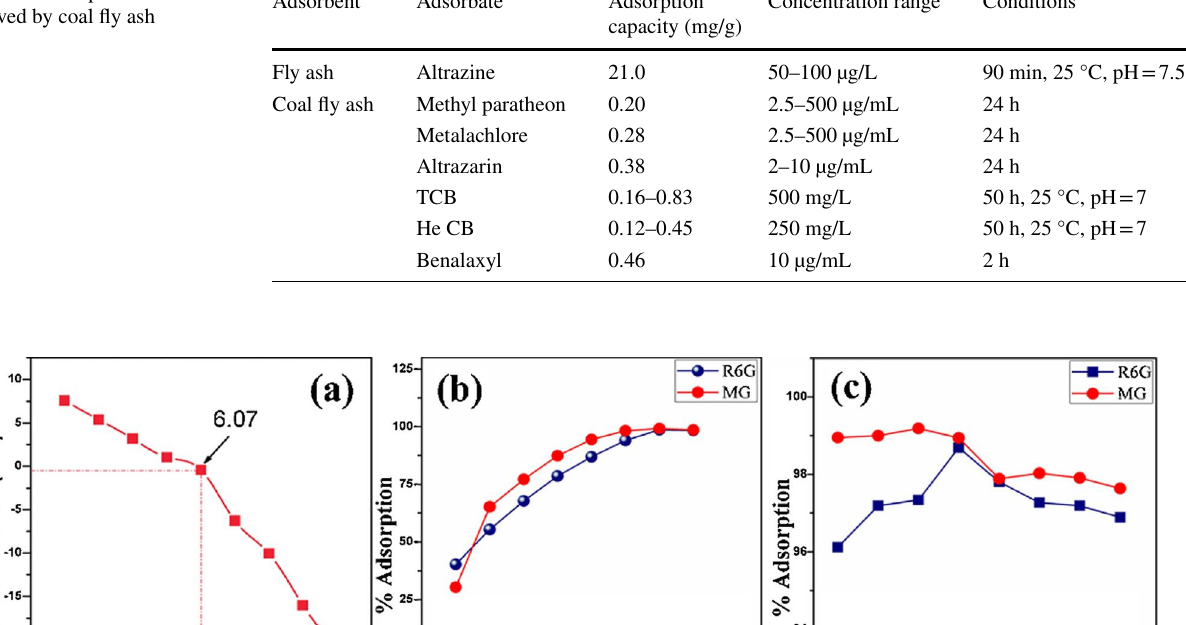
Table 5 List of pesticides removed by coal fly ash